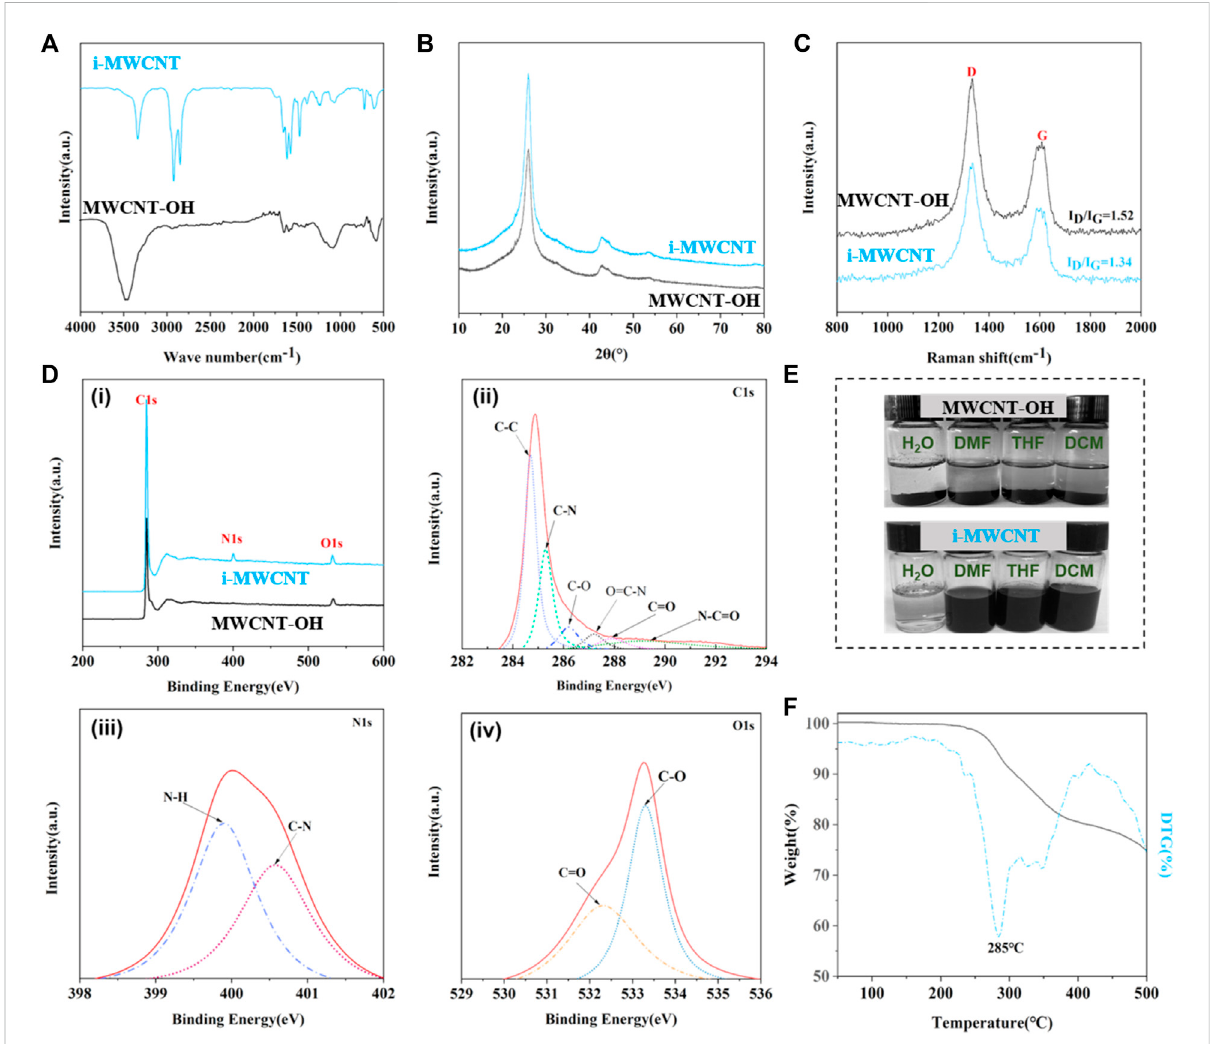
FIGURE 2 (A) FT-IR, (B) XRD, and (C) Raman spectra of MWCNT-OH and i-MWCNT. (D) XPS wide-scan spectra of MWCNT-OH and i-MWCNT (i: high- resolution elements, ii: C1s, iii: O1s, iv: N1s). (E) Photos of MWCNT-OH and i-MWCNT dispersed in various solvents. (F) i-MWCNT TG-DTG